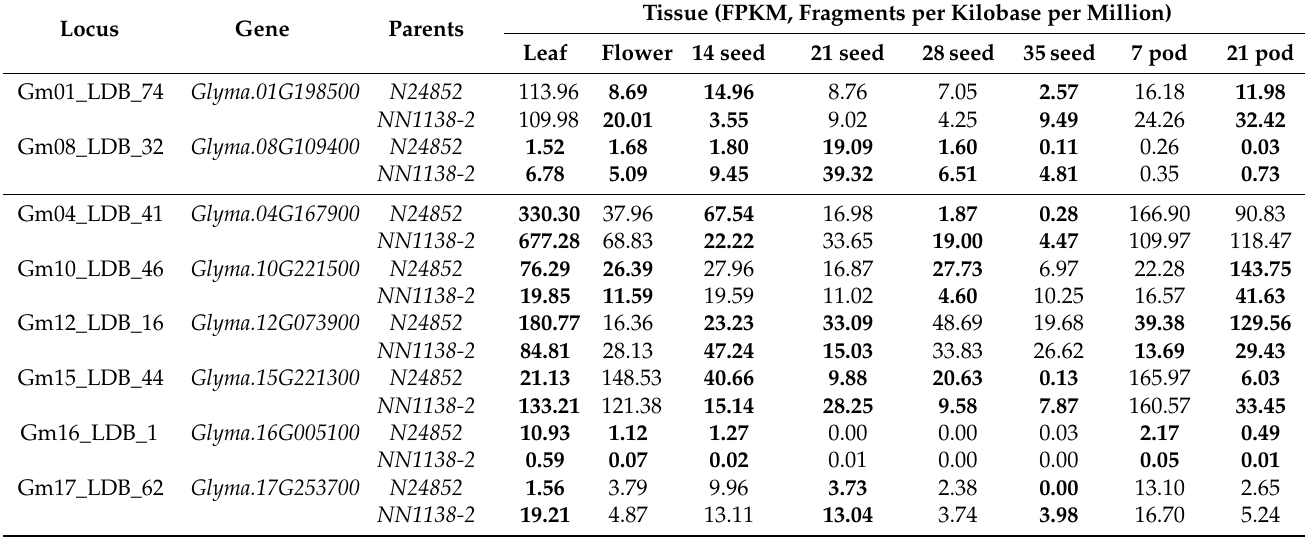
Table 3. Expression patterns of candidate genes related to SCC and DTF.